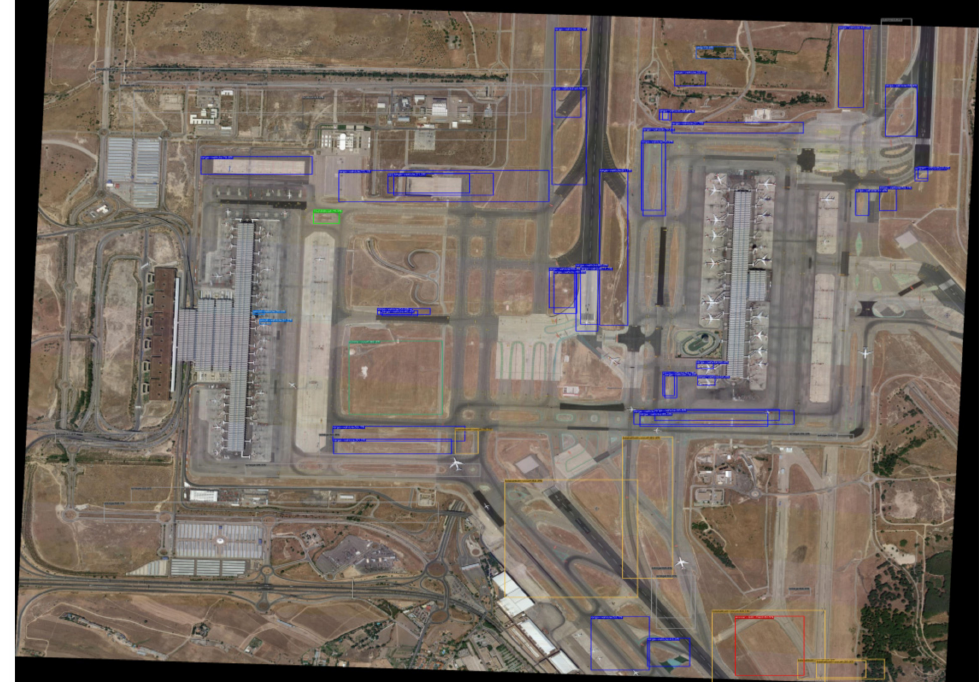
Figure 9. The detection result of putting a large-size image directly into the YOLOX mode.